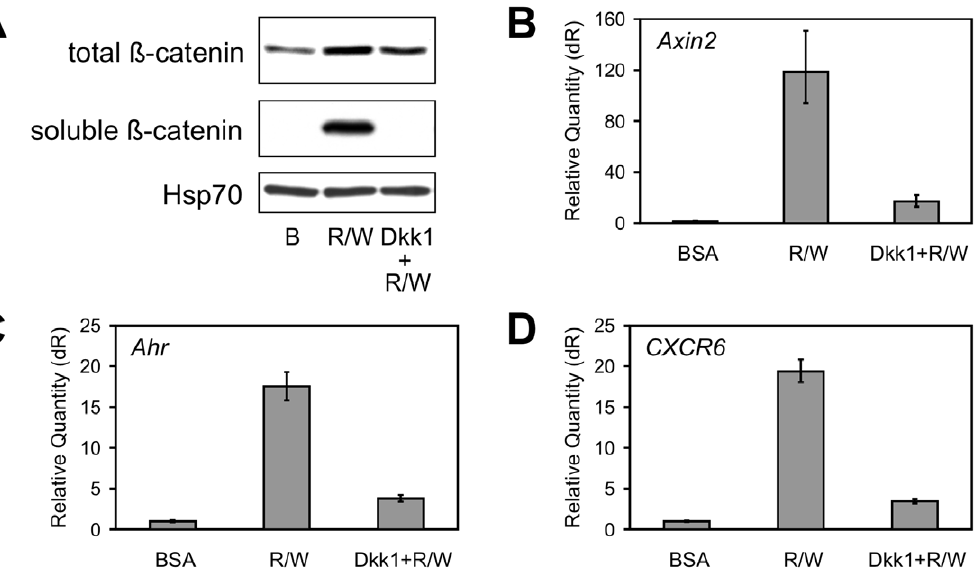
Figure 4. Dkk1 inhibited up-regulation of genes by Rspo2 and Wnt3a. ( A ) Immunoblot analysis of total b -catenin (cell lysate, 30 m g protein/ lane) and soluble b -catenin (GST-E-cadherin pull-down) from C57MG cells incubated for 3 h with BSA or Rspo2 (10 ng/ml) plus Wnt3a (100 ng/ml), with or without 20 min Dkk1 (1 m g/ml) pre-treatment. Western blot of Hsp70 was loading control. ( B–D ) Quantitative PCR analysis of Axin2 , Ahr and CXCR6 expression by C57MG cells after 24 h incubation with BSA or Rspo2 plus Wnt3a, with or without Dkk1 pre-treatment [experiment performed in parallel with (A), using the same reagent concentrations]. Results are means + / 2 S.D. of triplicate measurements from one of four representative